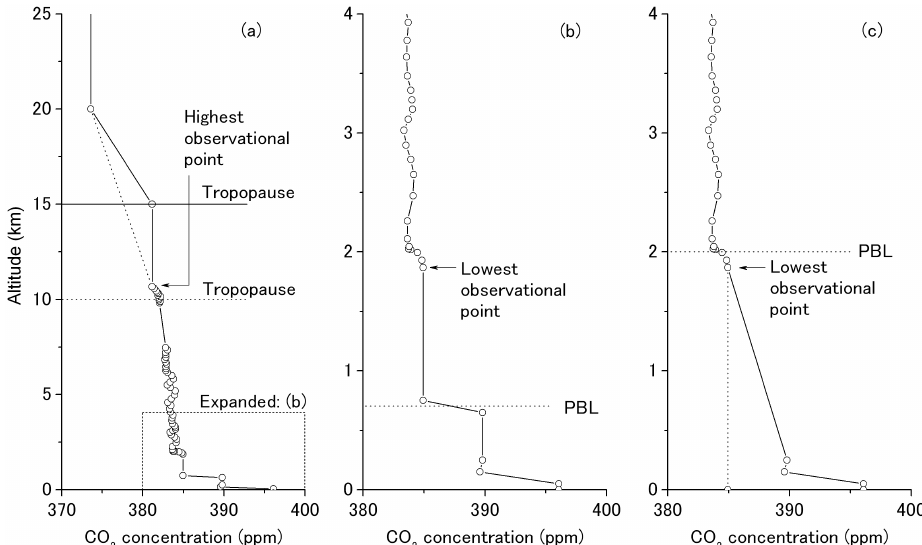
Fig. 1. CO 2 -profile assumption over Tsukuba. (a) High-altitude profiles: The solid and dotted lines show cases in which the tropopause is higher and lower, respectively, than the highest observational point by an airliner. The rectangular area is expanded in (b) and (c) . (b) Low-altitude profile: The PBL is lower than the lowest observational point. (c) Low-altitude profiles: the solid line shows a case in which the PBL is higher than the lowest observational point. The dotted line shows an example for which the meteorological-tower datum is missing. All type II analyses use a version of the dotted line in (c) for the low-altitude profile. The type I analysis is the case described in the